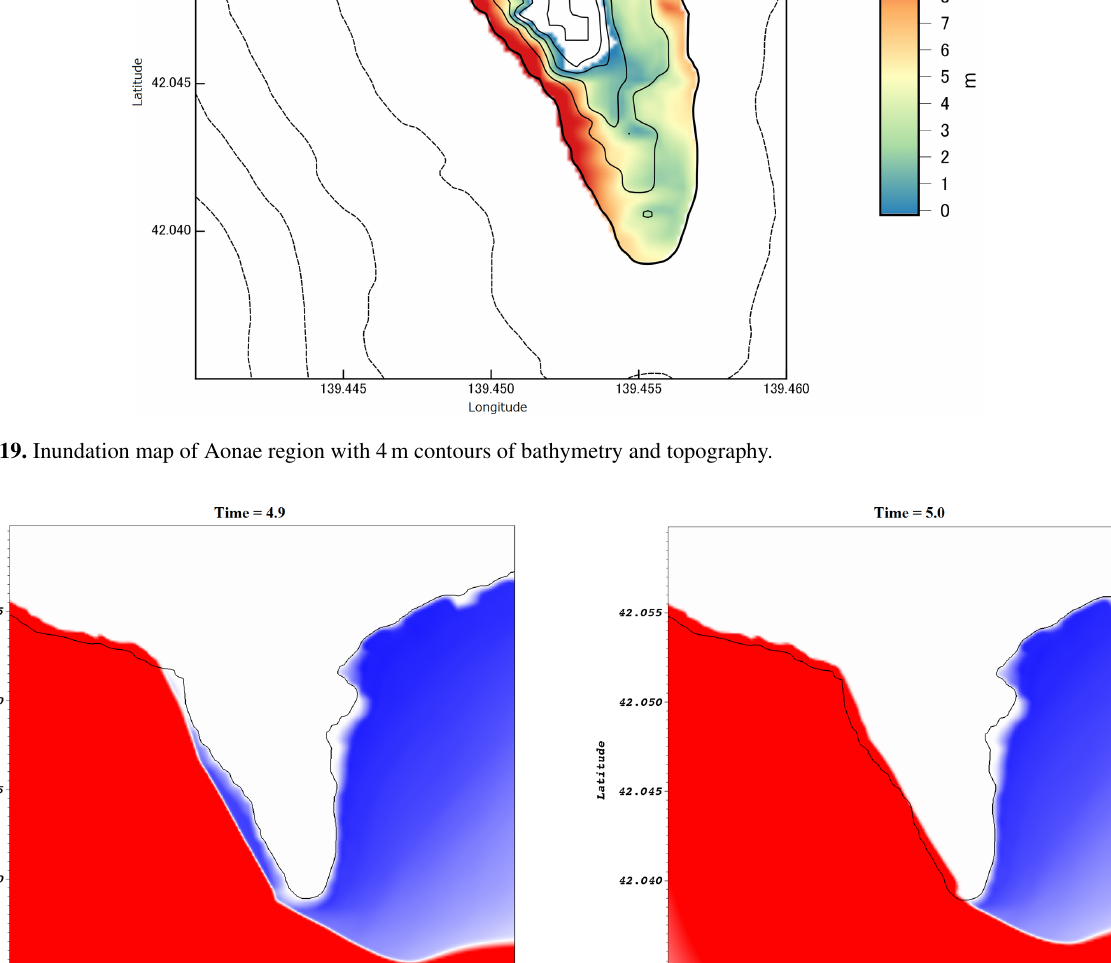
Arrival of first wave to Aonae The arrival of the first wave at Aonae peninsula is shown